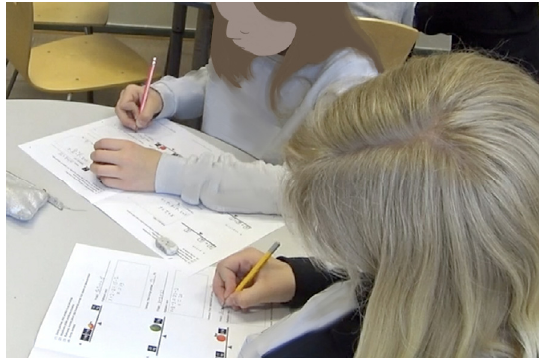
Figure 3. No peer interaction. students St 21 (B) and St 22 (C), in the paper-and-pencil group, working on their own worksheets quietly and separately.